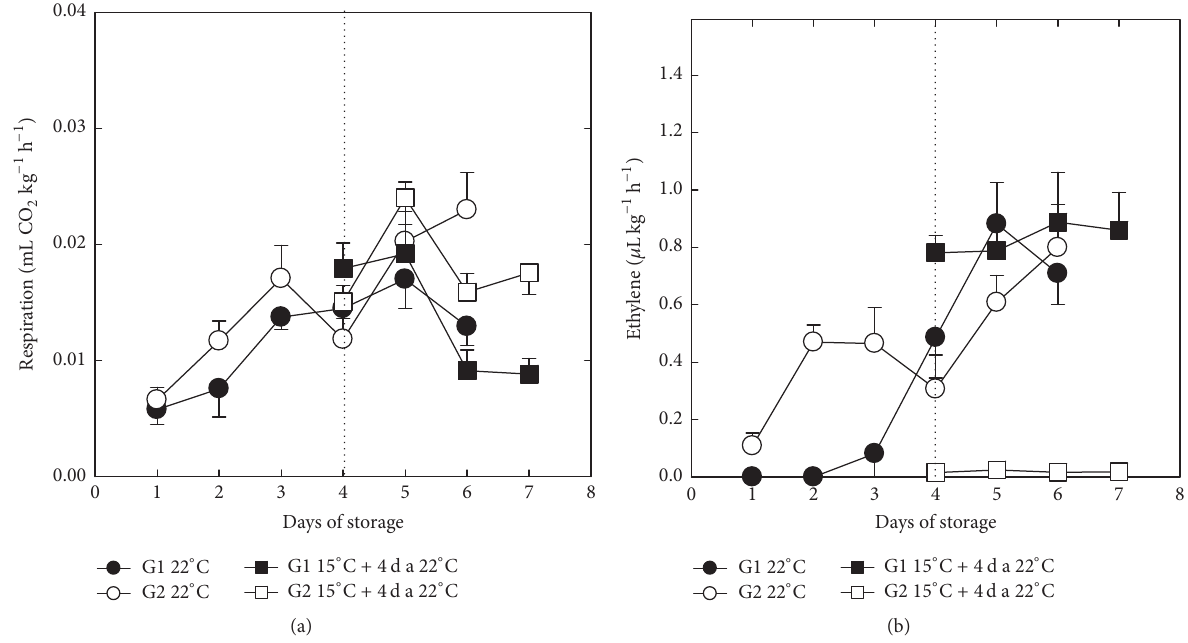
Figure 1: Respiration (a) and production of ethylene (b) in fruit from two selections of soursop stored at 22 and 15 ∘ C. Each point represents the average of 6 observations ± standard error. The dotted line indicates removal from